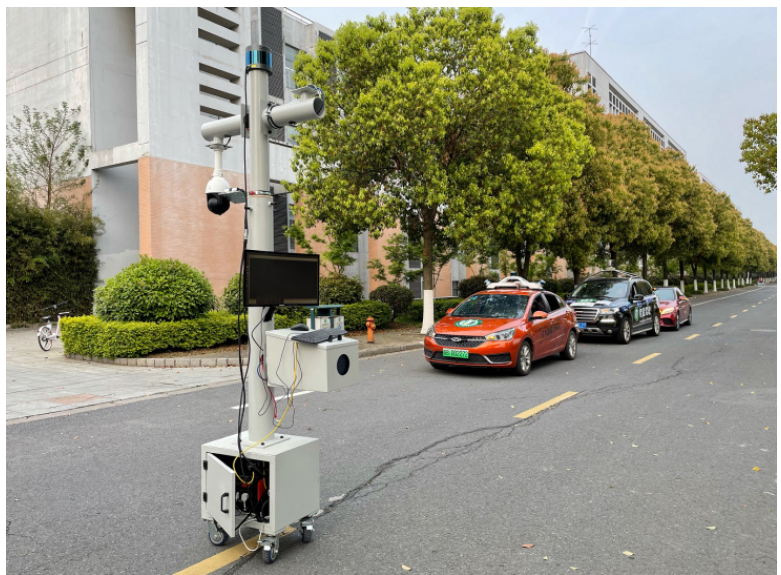
Figure 8. The road–vehicle collaborative perception mobile and roadside prototype platform.